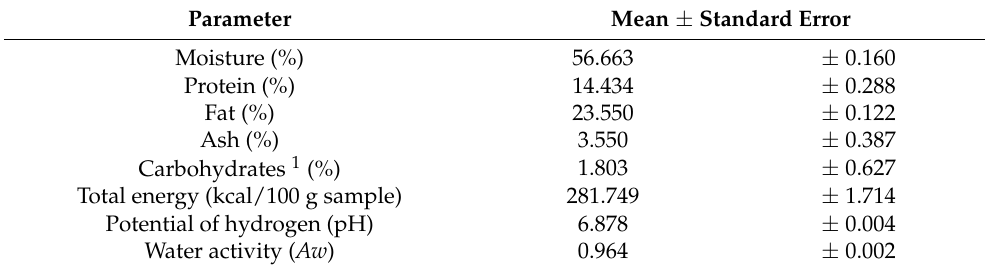
Table 3. Physicochemical characterization of vacuum-packaged cooked sausages ( n = 3).